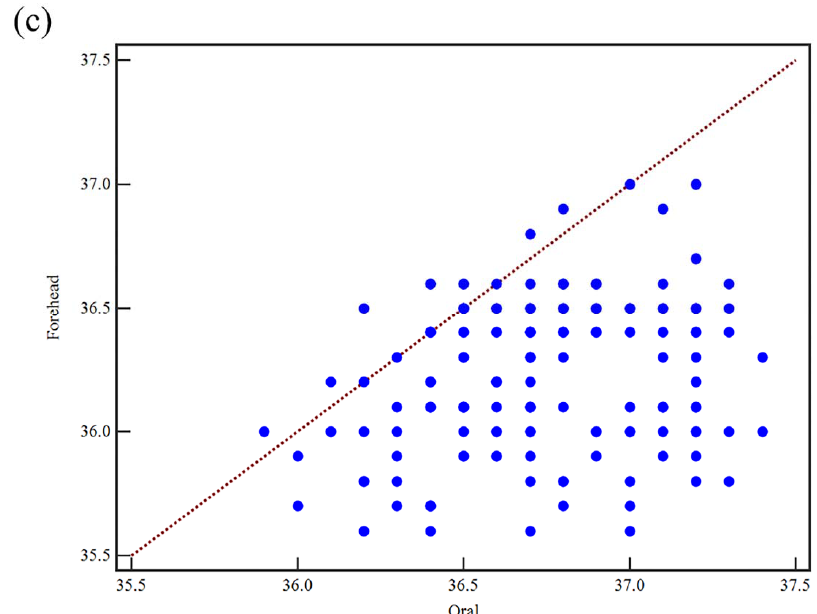
Figure 2. Scatter diagram of the correlation between the axillary temperature, oral temperature and forehead temperature; ( a ) correlation between the axillary temperature and oral temperature data (r = 0.41; p < 0.001; 95% CI, 0.28–0.52), ( b ) correlation between the axillary and forehead temperature data (r = 0.07; p = 0.33; 95% CI, − 0.07–0.22), ( c ) correlation between the oral and forehead temperature data (r = 0.26; p < 0.001; 95% CI, 0.11–0.39).